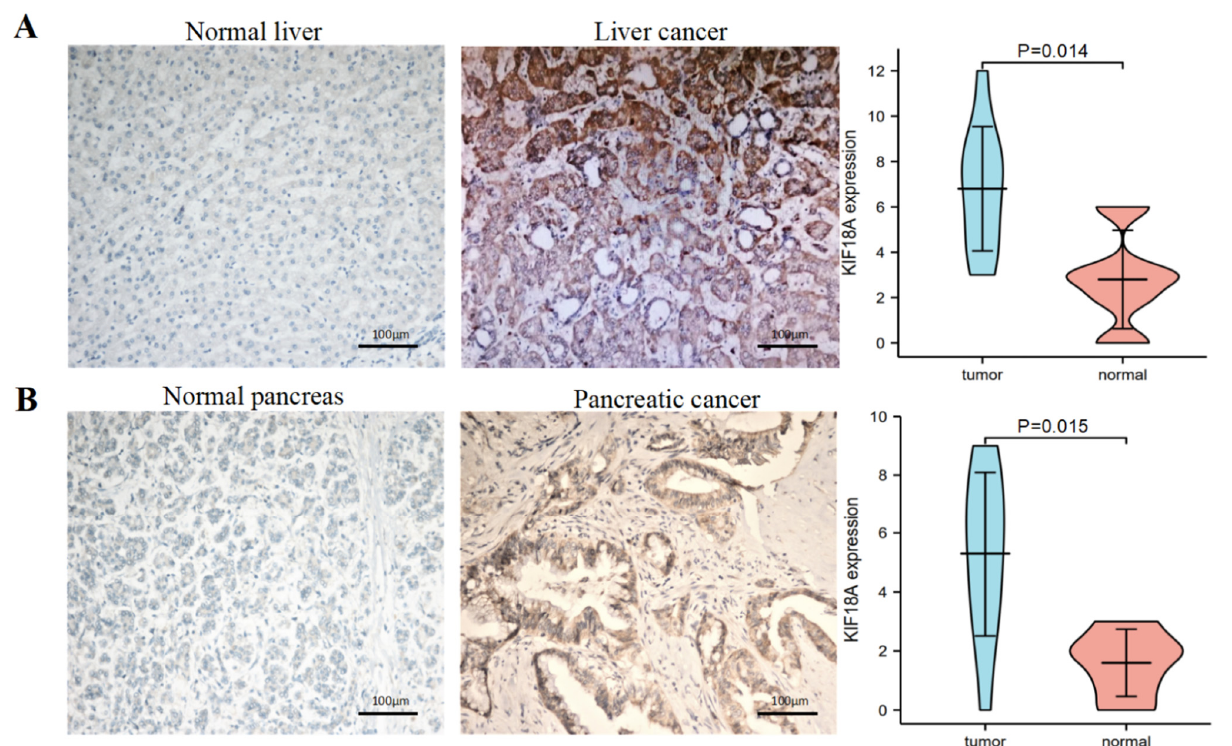
Figure 12. KIF18A protein expression in tumors and normal tissues by immunohistochemistry (EnVision; original magnification, × 200). ( A ) The expression of KIF18A protein was higher in liver cancer than normal liver tissue. ( B ) The expression of KIF18A protein was higher in pancreatic cancer than normal pancreas tissues.